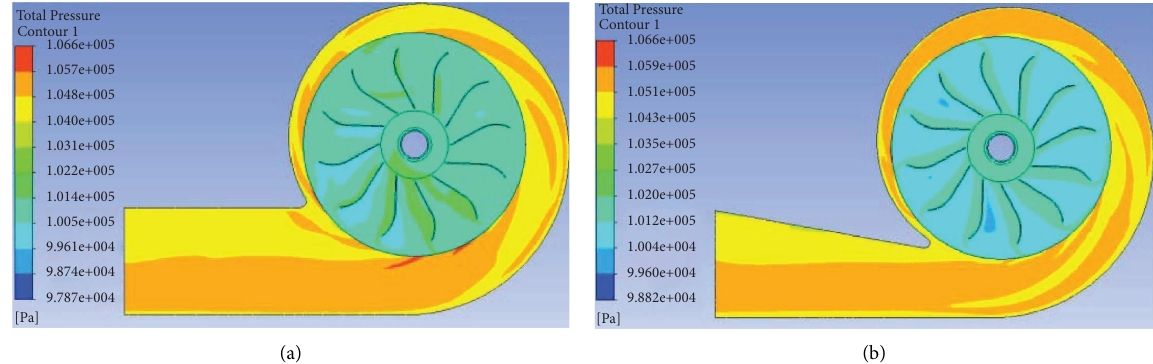
Figure 13: Total pressure distribution: (a) before optimization and (b) after optimization.